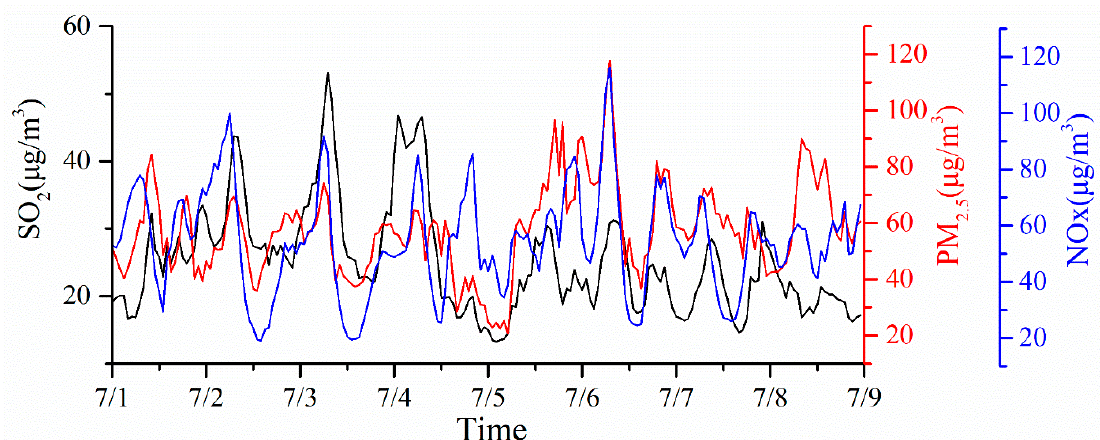
Figure 5. Observed pollutant concentrations in Shanghai on 1–8 July 2011.